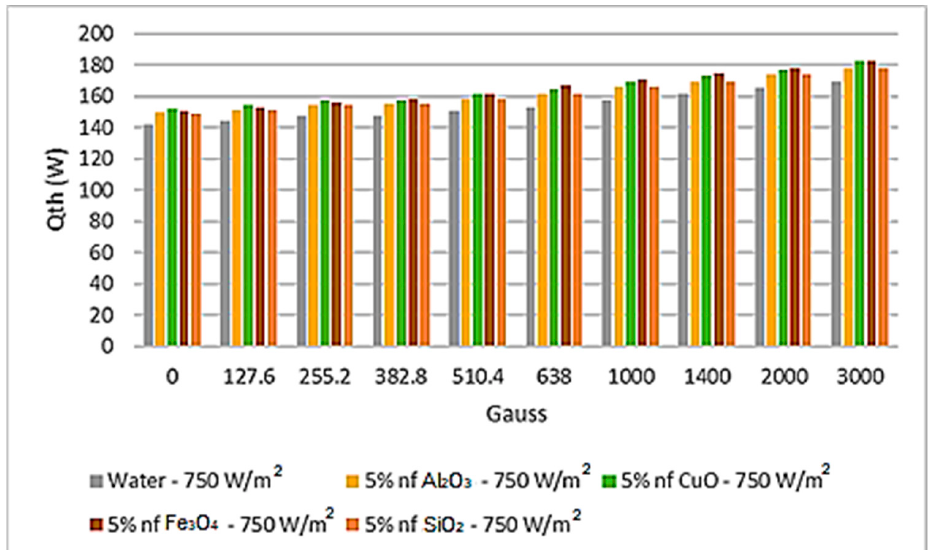
Figure 21. Thermal energy transferred to nanofluids from PV-Th solar panels.